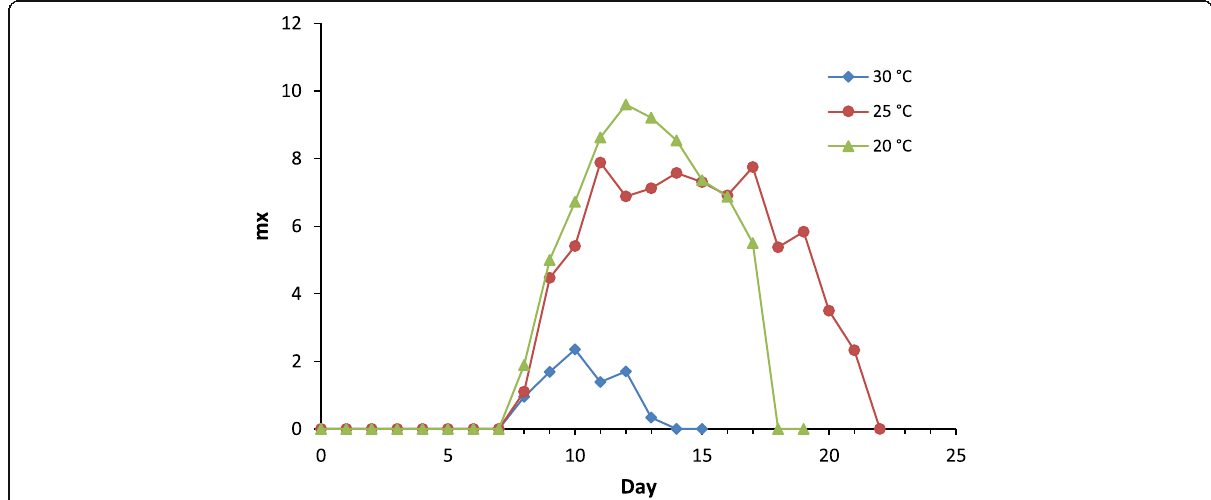
Fig. 2 Number of females produced/female/day ( mx ) by Aphidius matricariae parasitizing Schizaphis graminum at various